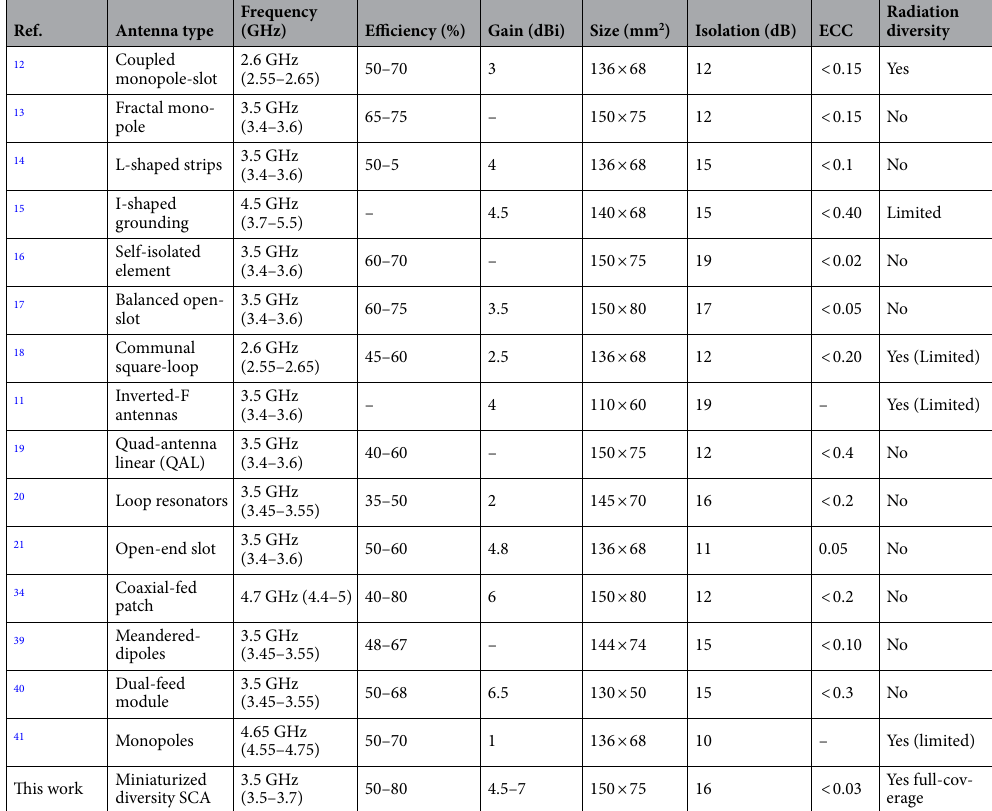
Table 2. Comparison Table of the introduced MIMO smartphone antenna.